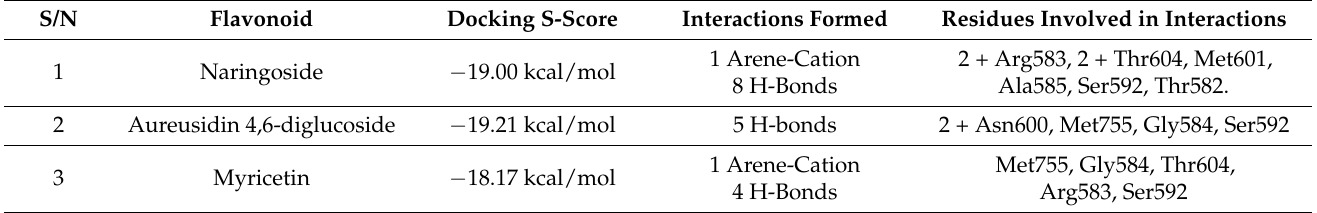
Table 2. Flavonoids, which we screened against the RdRp enzyme allosteric site. The columns show the binding affinity energy (docking S-Score), and RMSD refine values calculated during molecular docking. The number and types of interaction they formed with the allosteric site amino-acid residues are also